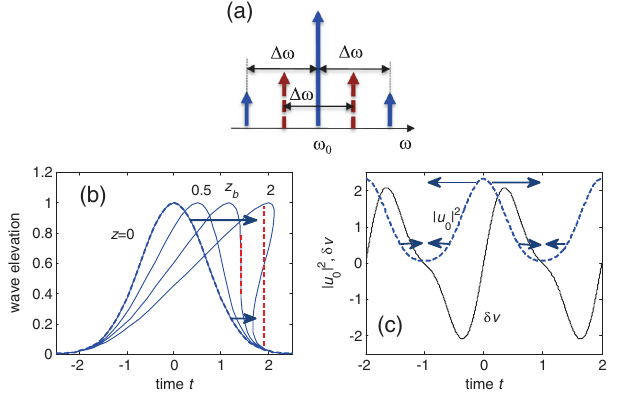
FIG. 1. (a) Sketch of the input in frequency domain showing the triple-frequency (solid blue arrows) and dual-frequency (dashed brown arrows) cases, respectively. (b) Generic mecha- nism of wave breaking via a gradient catastrophe (length of the arrows is proportional to the local velocity at the point of application over the input; the dashed vertical line is the classical shock wave). (c) Initial power profile j u 0 ð t Þj 2 and instantaneous incremental velocity δ v ð t Þ resulting from the nonlinear self- phase modulation for triple-frequency input [ η ¼ 0 . 8 , α ¼ 0 , m ¼ 1 in Eq. (1)].